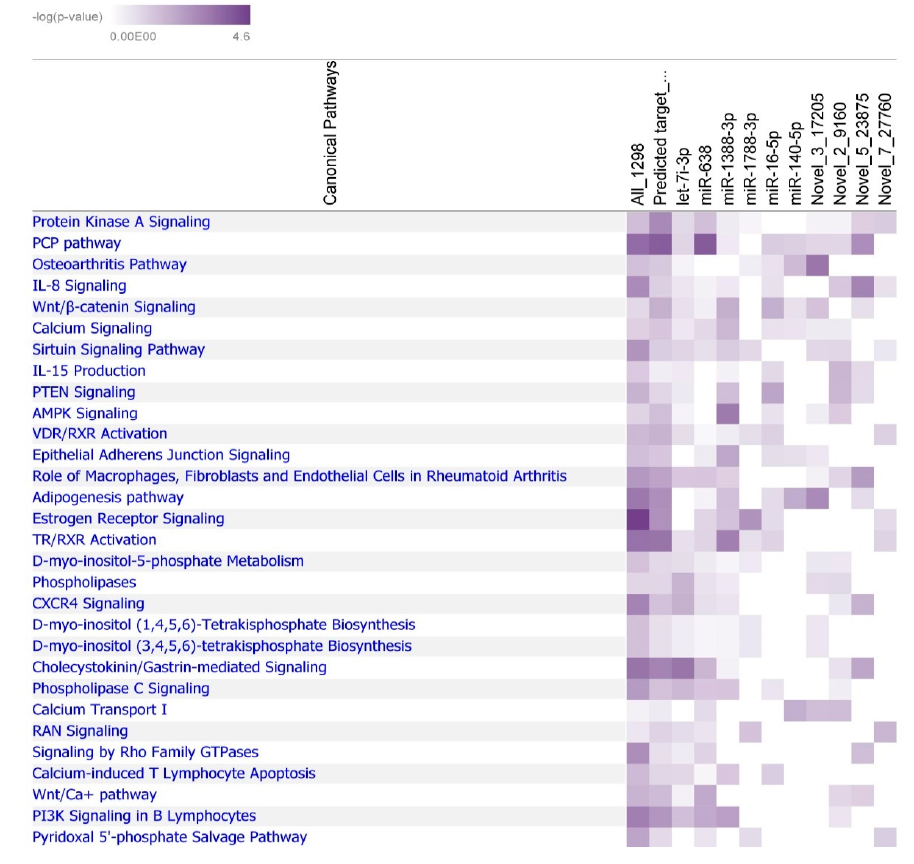
Figure 3. Heatmap showing enriched canonical pathways derived from analyses of miRNAs and corresponding mRNAs based on (1) negative correlation of expression in the same samples (All_1298), (2) negatively correlated expression and target prediction, and (3) negative correlated and predicted target transcripts of let-7i-3p, miR-638, miR-1388-3p, miR-1788-3p, miR-16-5p, miR-140-5p, novel-3-17205, novel-2-9160, novel-5-23875, and novel-7-27760. The intensity of color indicates significance from light to dark.